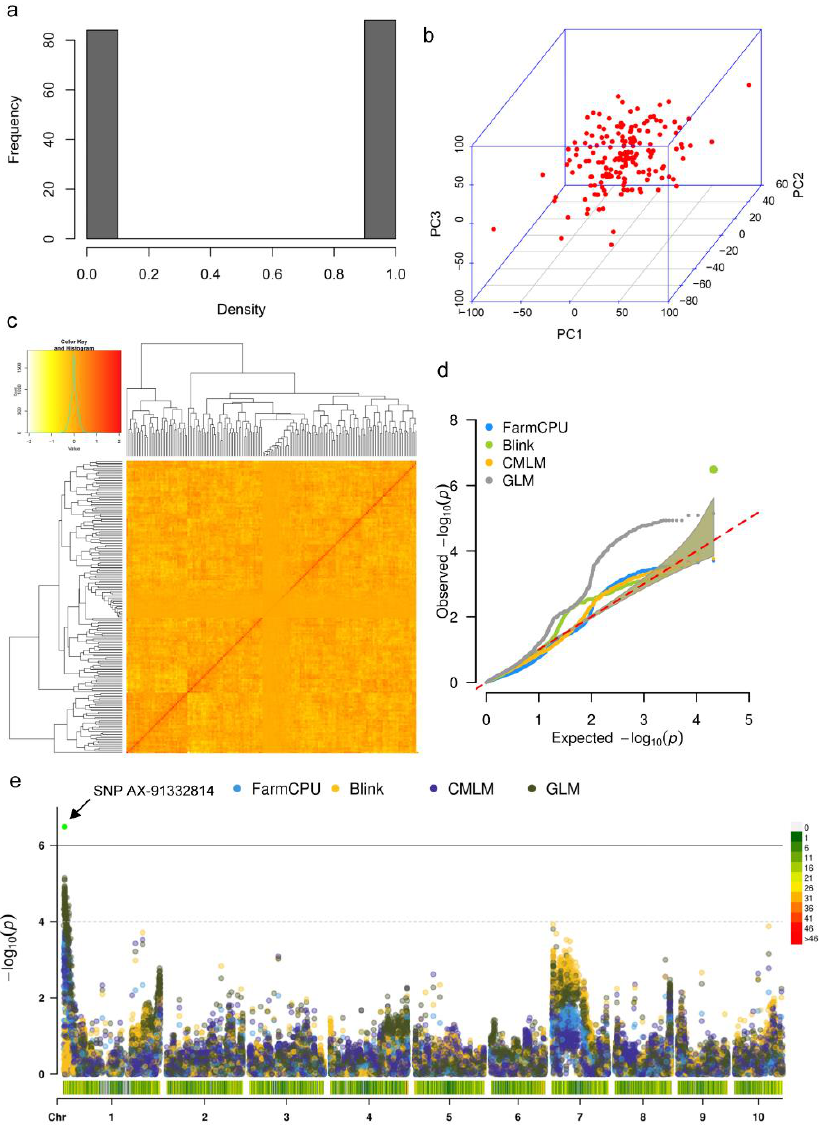
Figure 4. GWAS results of the seed germination speed in the F 2 population derived from line 72-3 and line F9721. ( a ) The distribution histogram of selected F 2 lines, 1 indicates the fast germinated individuals/pools, and 0 indicates the slow germinated individuals/pools. ( b ) 3-Dimensional scatter plot of first three PCA. ( c ) Pair-wise individual relatedness matrix computed by GAPIT3.0. ( d ) The quantile-quantile (Q-Q) plot of multiple GWAS models for seed germination speed. ( e ) Manhattan plot of association using four GWAS models, the bottom heatmap shows the SNP density on the ten chromosomes of maize genome.